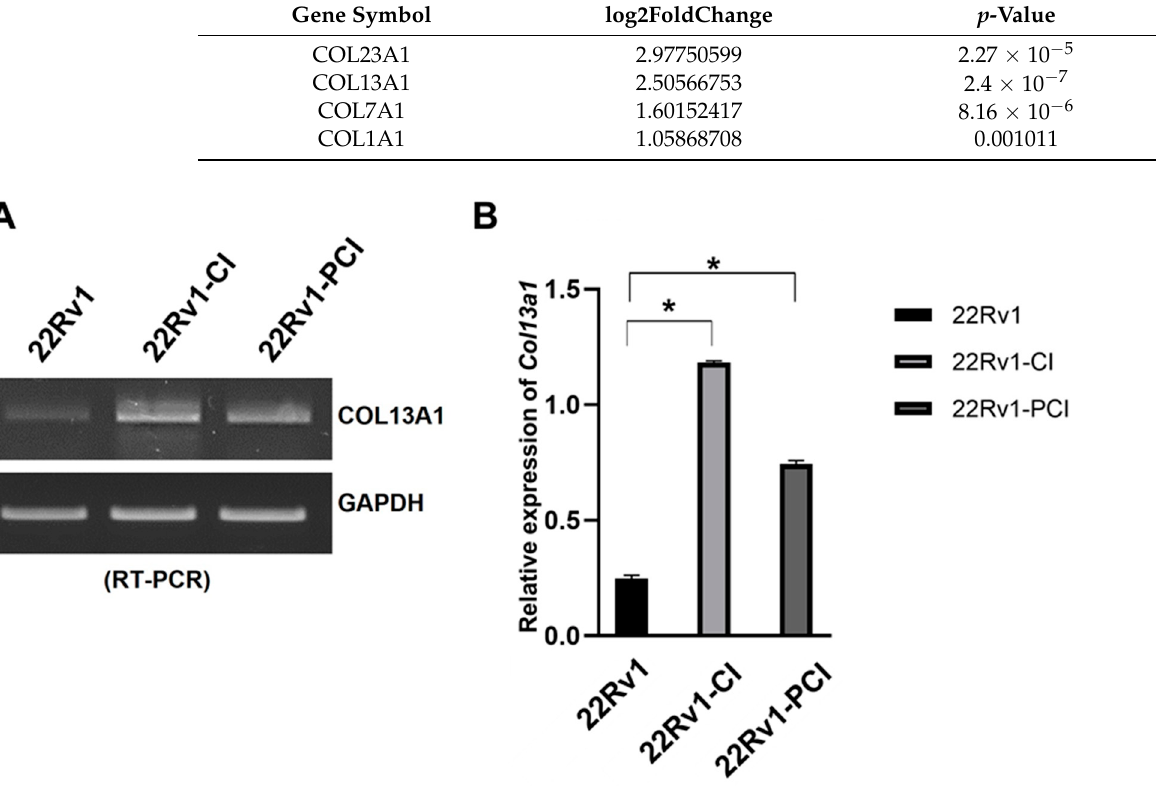
Figure 4. mRNA expression of COL13A1 22Rv1-CI, and 22Rv1-PCI cells compared with 22Rv1 cells. ( A ) mRNA expression of COL13A1 in 22Rv1 cells or cells with repeated H–R cycles. ( B ) Bar graph represents the expression of COL13A1. Data are mean ± SEM. * p < 0.05.